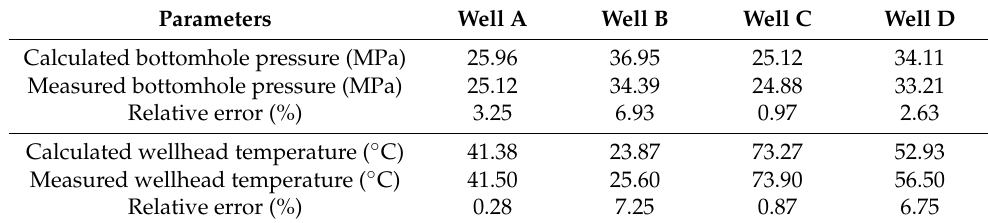
Table 6. Calculation results of model application.